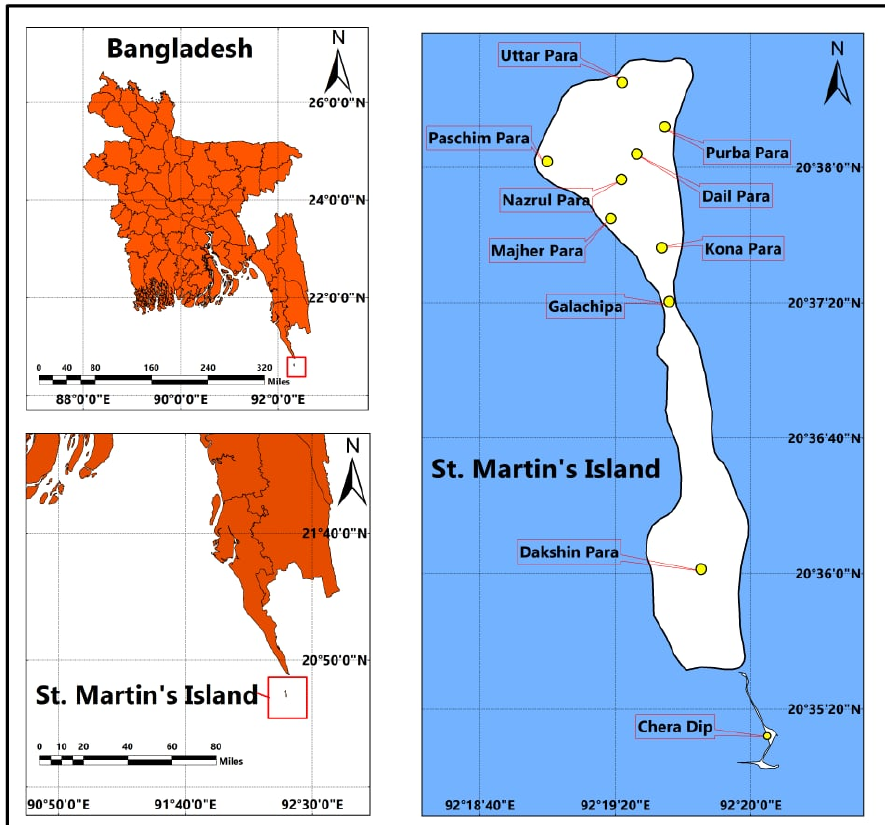
Figure 3. Saint Martin’s Island and study